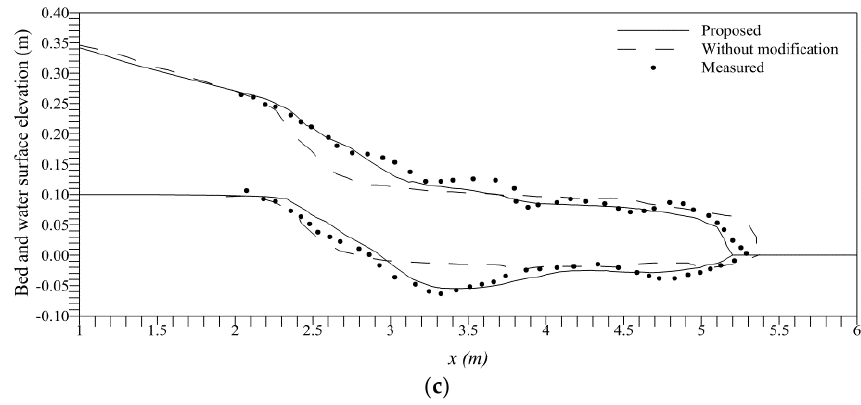
Figure 7. Numerical and experimental results of dam-break for Configuration 3: ( a ) t = 0.25 s; ( b ) t = 0.75 s; and ( c ) t = 1.25 s.